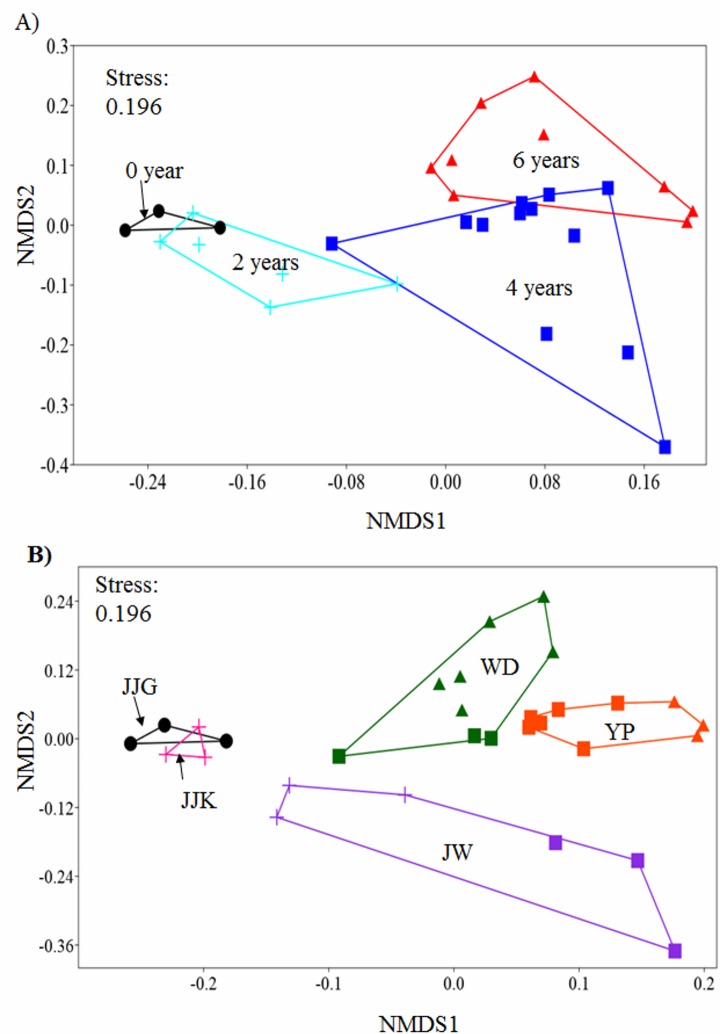
Non-metric multidimensional scaling (nMDS) plots of the core bacterial families in 30 soil samples.(A) nMDS plots show dissimilarities between cultivation years: non-cultivated (black), 2-year-old (aqua), 4-year-old (blue), and 6-year-old (red) samples. (B) nMDS plots show dissimilarities based on geography: Jajangri (JJG, black), Jajakri (JJK, pink), Wondangri (WD, darkgreen), Juwonri (JW, violet), and Yulpori (YP, orange).